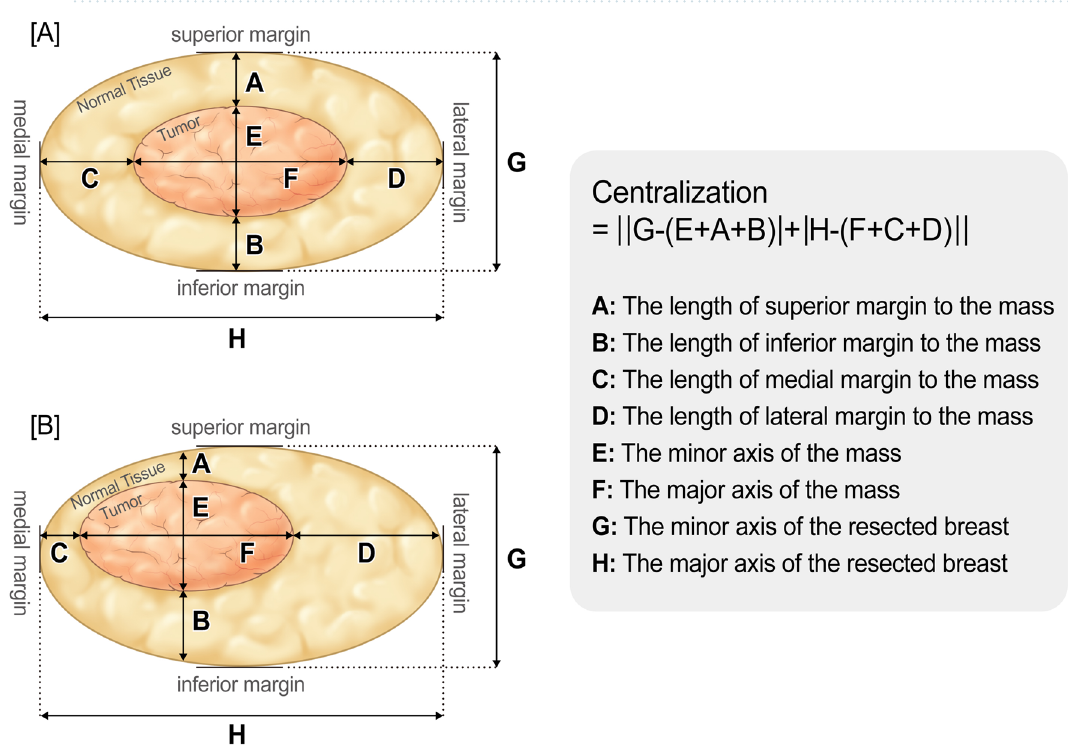
Figure 3. The lesion centralization (diagram). Diagram illustrating the current model for the lesion centralization. The formula of the centralization is next. Centralization = ||the major axis of the resected breast – ( the major axis of the mass + the length of superior margin to the mass + the length of inferior margin to the mass ) | + |the minor axis of the resected breast- ( the minor axis of the mass + the length of medial margin to the mass + the length of lateral margin to the mass ) ||. The closer the calculated value was to zero, the more the lesion was centralized. “A” model was more centralized than “B” model. This work was drawn by the Creative Media Service in National Cancer Center